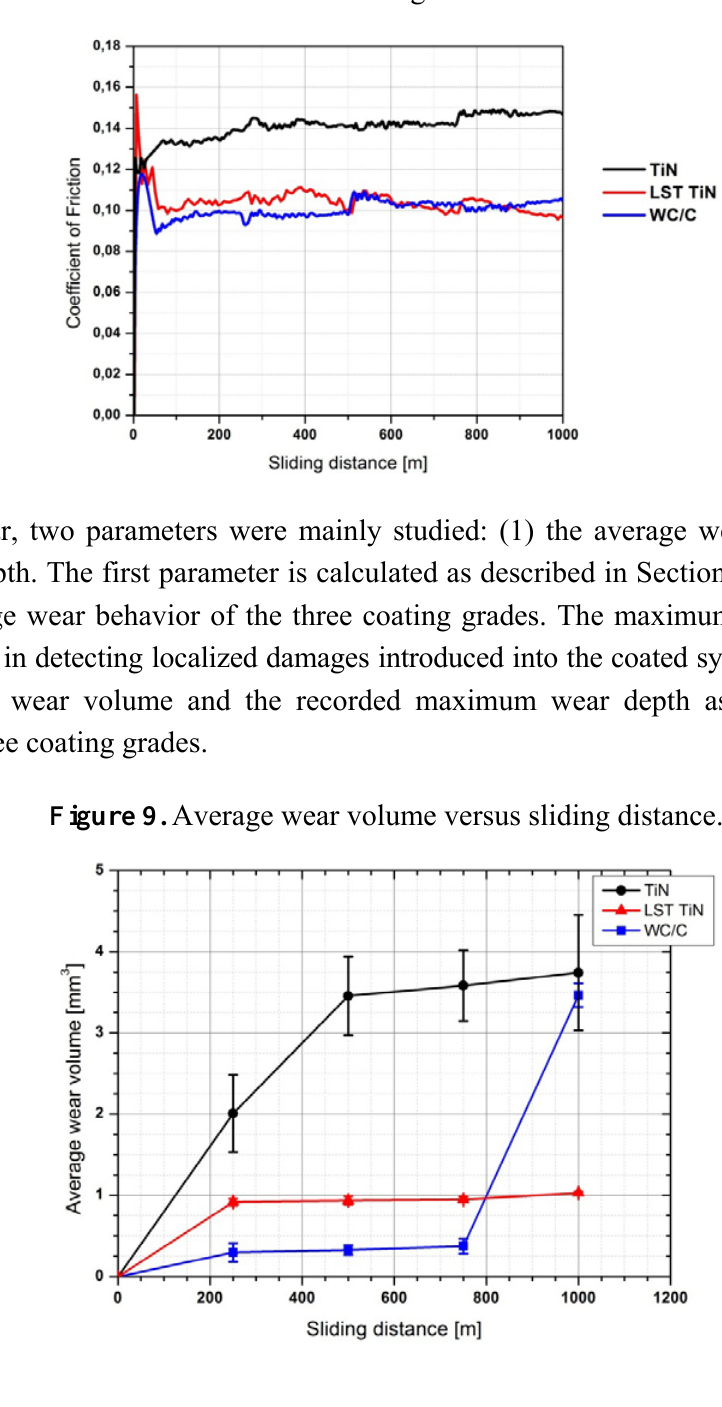
Figure 8. Friction coefficient versus sliding distance for the three coating grades.